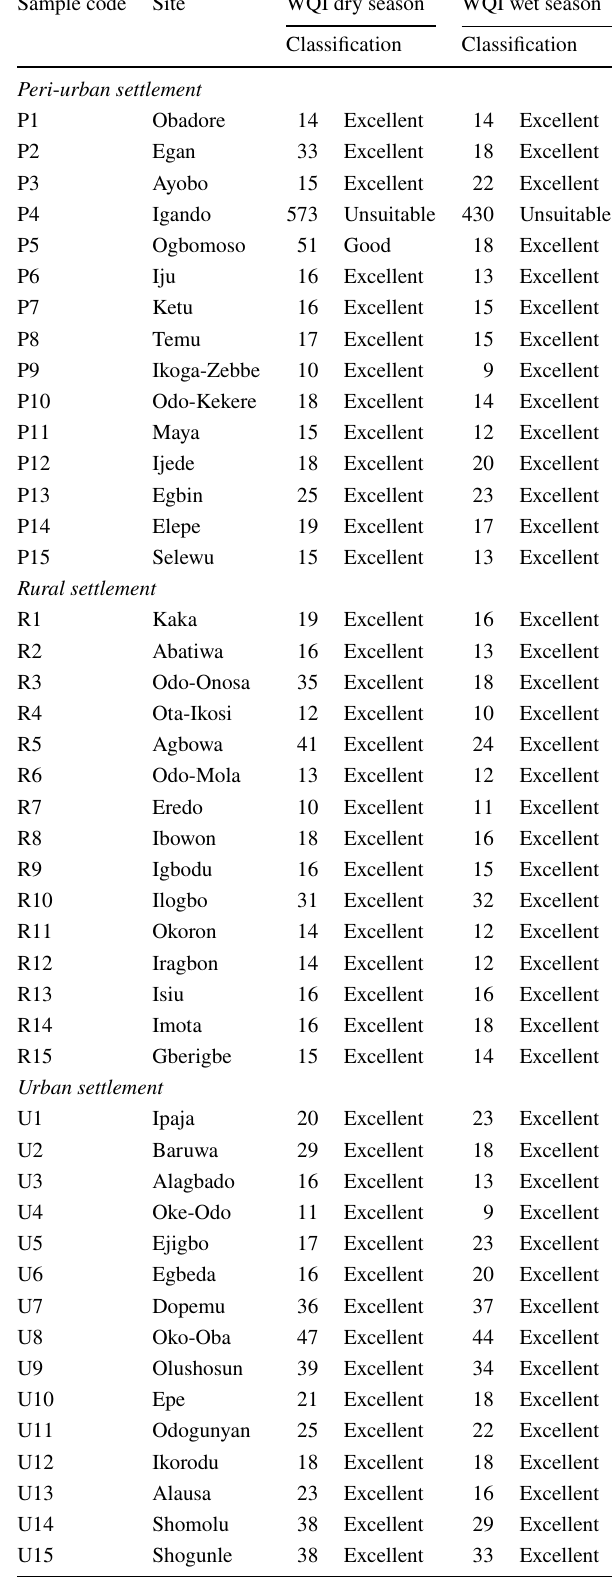
Table 6 Water quality index and classification in the study